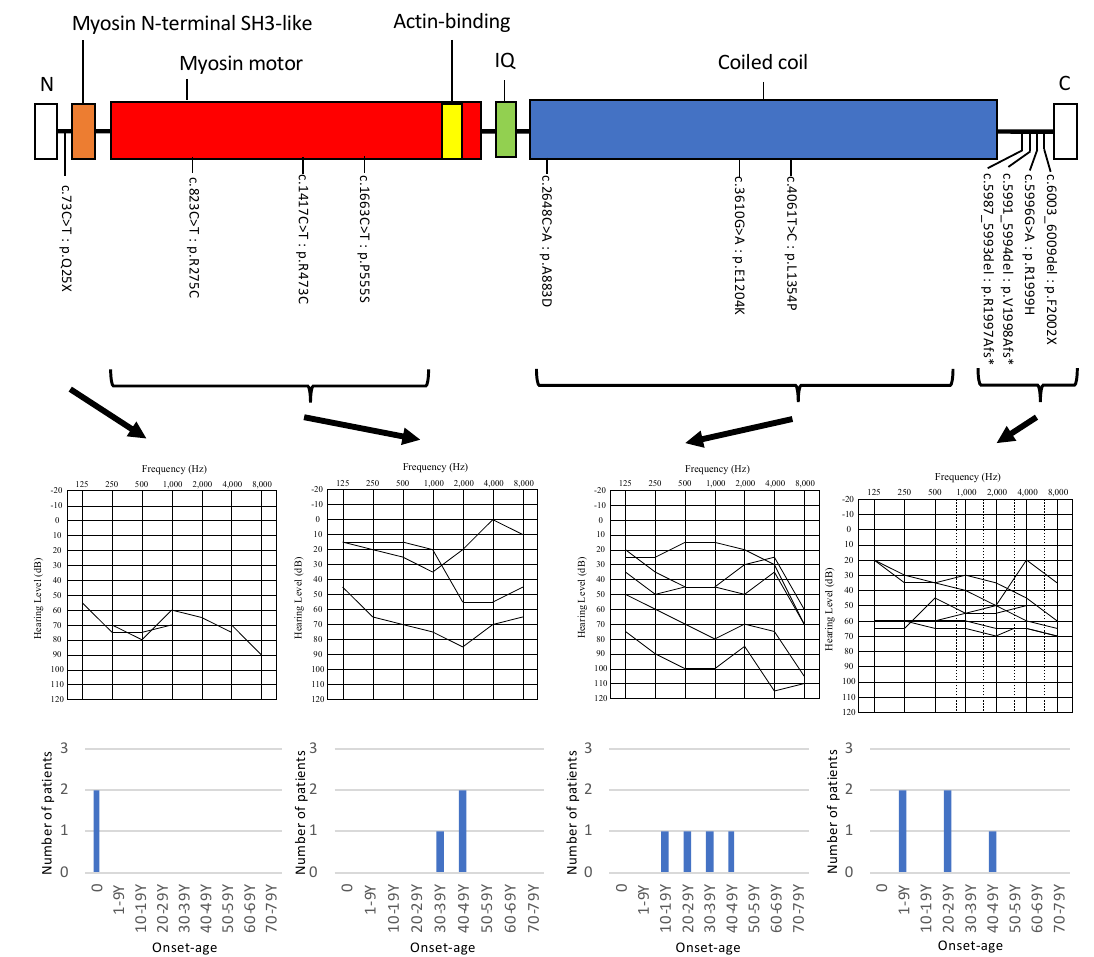
Figure 2. Domain structure of MYH14, identified variants, the overlapping audiograms from the better-hearing ear, and onset-age distribution for the patients with each domain variant. Domain structures are indicated based on UniProtKB (Q7Z406). Orange: Myosin N-terminal SH3 like domain, Red: Myosin motor domain, Yellow: Actin binding domain, Green: IQ domain, Blue: Coiled coil domain.